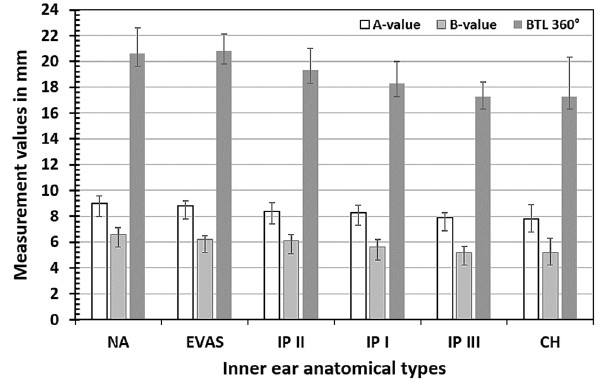
Figure 3. The mean and standard deviation of A-, B-value, and measured basal turn length (BTL) (360° coverage) for various inner ear anatomical types.